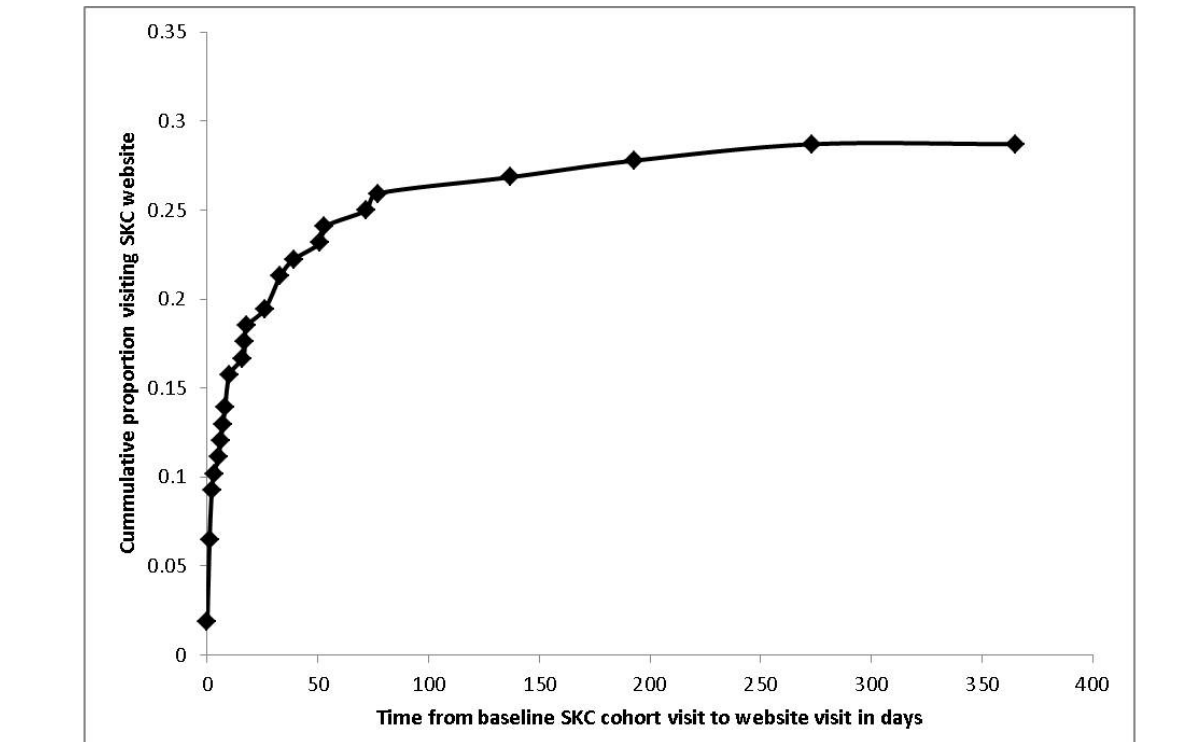
Figure 2. Cumulative incidence of Safe Kidney Care website